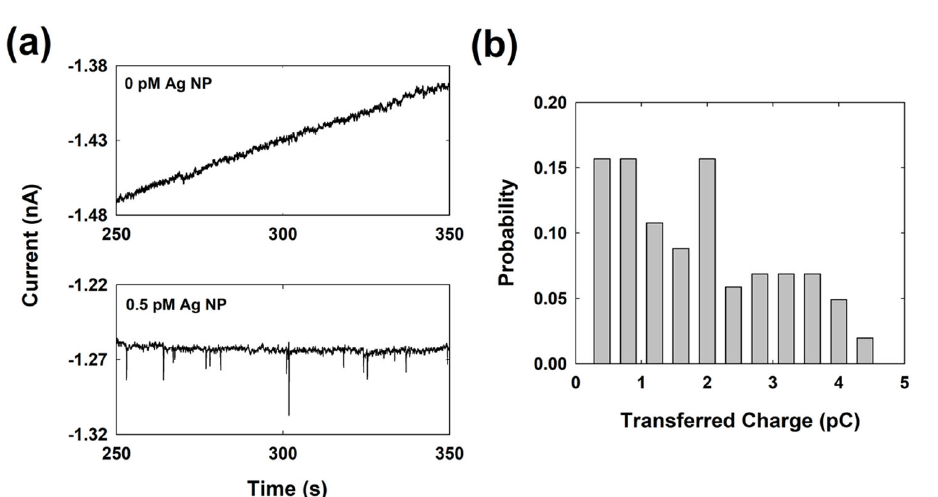
Figure 3. ( a ) Chronoamperometric curves at 0.7 V applied to a Cu UME in a 0.1 M NaOH solution with/without Ag NPs in the absence of hydrazine. ( b ) Transferred charge distribution of a spike like current response for a single Ag NP collision in the absence of hydrazine. The average transferred charge is 1.8 ± 1.1 pC.